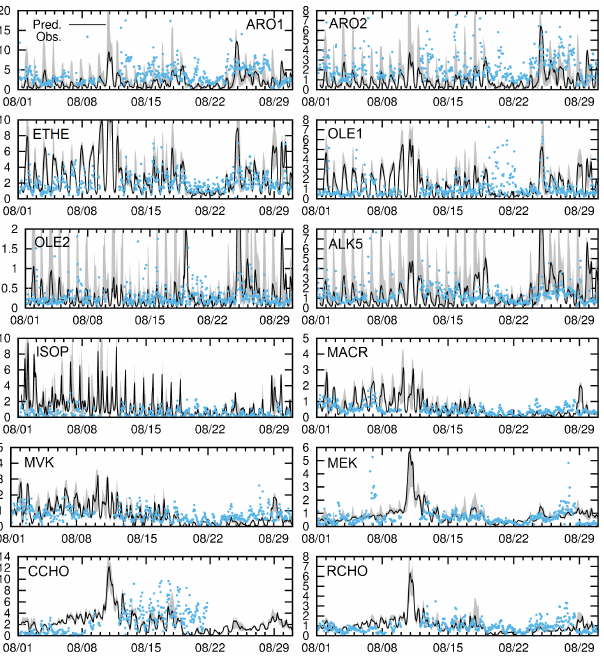
Figure 2. Predicted and observed August VOC concentrations in Nanjing. Observed concentrations are based on individual VOCs lumped into the SAPRC-11 model species. Shaded areas represent the range of predictions in the nine grid cells with the monitor site at the center. Units are